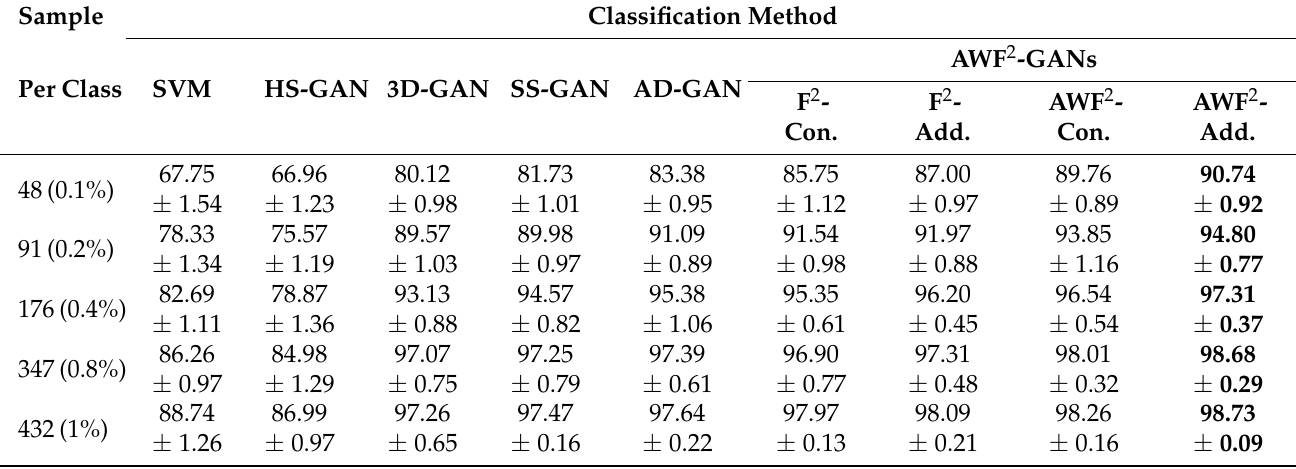
Table 6. The overall accuracy (OA) of classification methods on the UP dataset using various percentages of training samples. The best performances for each test case are in